Question: What style of plot is this figure drawn as?
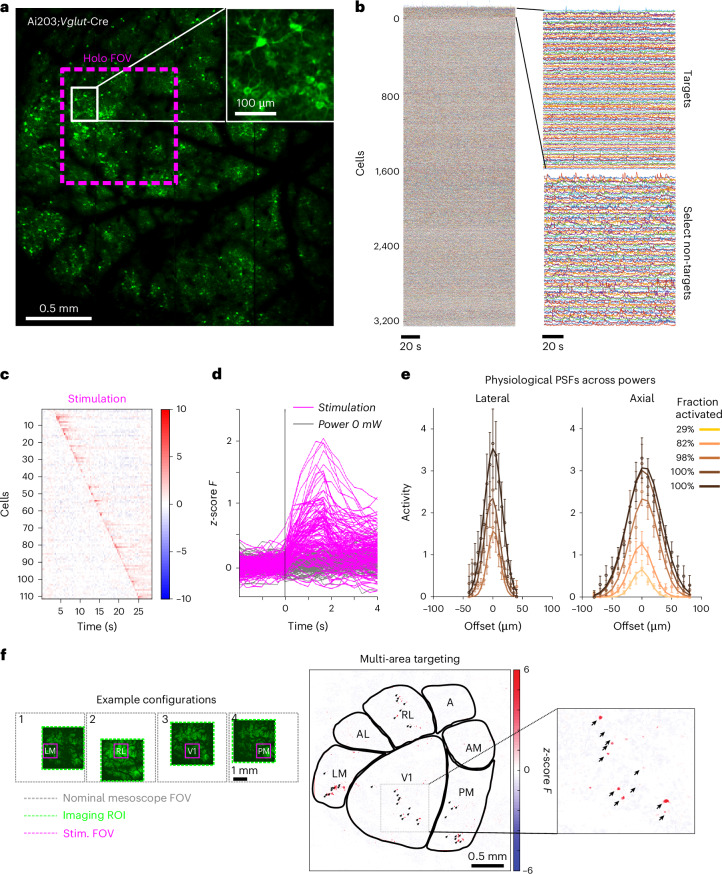
Answer: bar